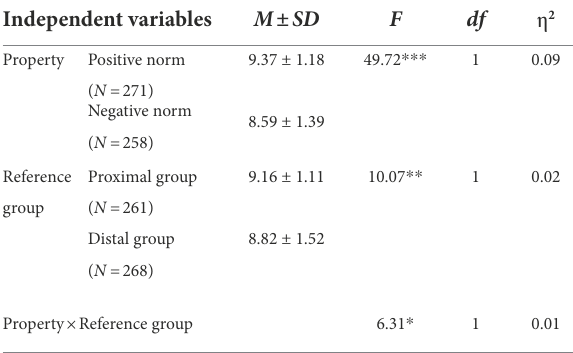
TABLE 2 The main effects and the interaction effect of the property and the reference group of descriptive norms on public health compliance behaviors.